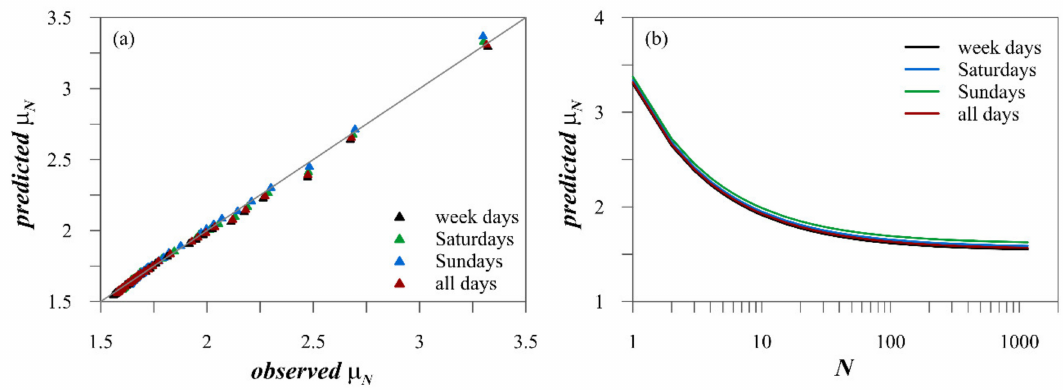
Figure 5. ( a ) Accordance between expected values of sample means estimated by Equations (6) and (7) for all the Clusters. ( b ) Comparison among calibrations of Equation (7) performed on the di ff erent